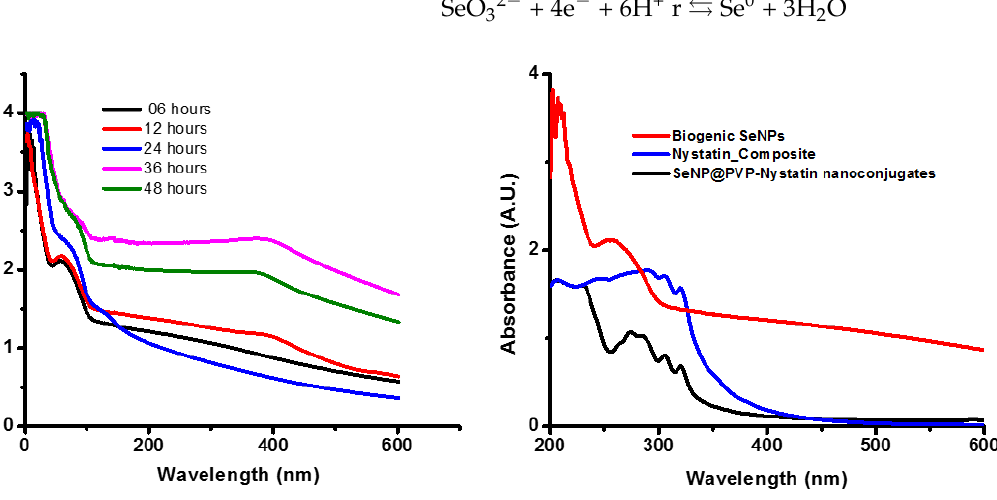
Figure 1. Ultraviolet–visible (UV-Vis) spectra of biogenic SeNPs, Nystatin_Composite, and SeNP@PVP_Nystatin nanocomposites. The absorption peak at 270 nm for the synthesis of bio- genic SeNPs at different time interval periods shows that the synthesis of biogenic SeNPs increases with an increase in the incubation period (left); absorption peaks of biogenic SeNPs upon function- alization with nystatin (SeNP@PVP_Nystatin nanoconjugates) show additional peaks at 289, 303, and 318, which are characteristic peaks for nystatin. The Nystatin_Composite also shows nystatin characteristic